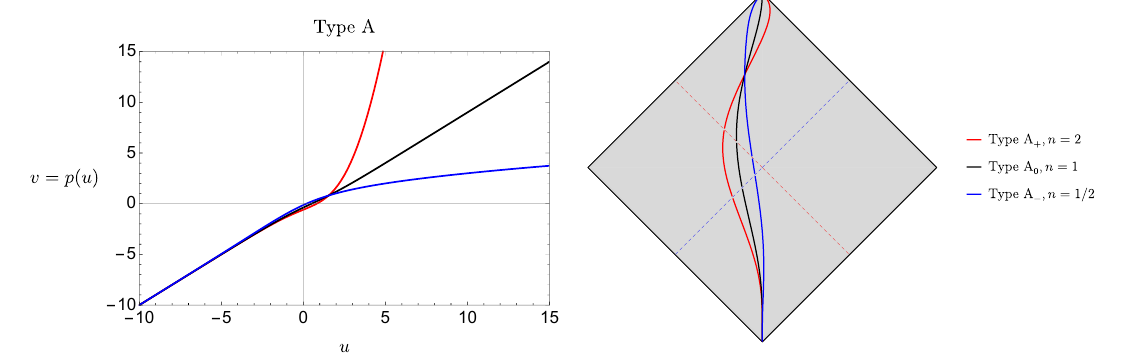
Figure 4 . Type A mirrors with differently chosen p A ( u ) as introduced in eq. (2.14). The three subclasses type A , A , A are defined in table 2. Left: shown are different types of conformal + 0 − mapping functions with n = 2 , 1 , 1 , respectively, see also table 2. Right: corresponding trajectories 2 of moving mirrors are shown in a Penrose diagram. For both plots, we have chosen β = 1 = u